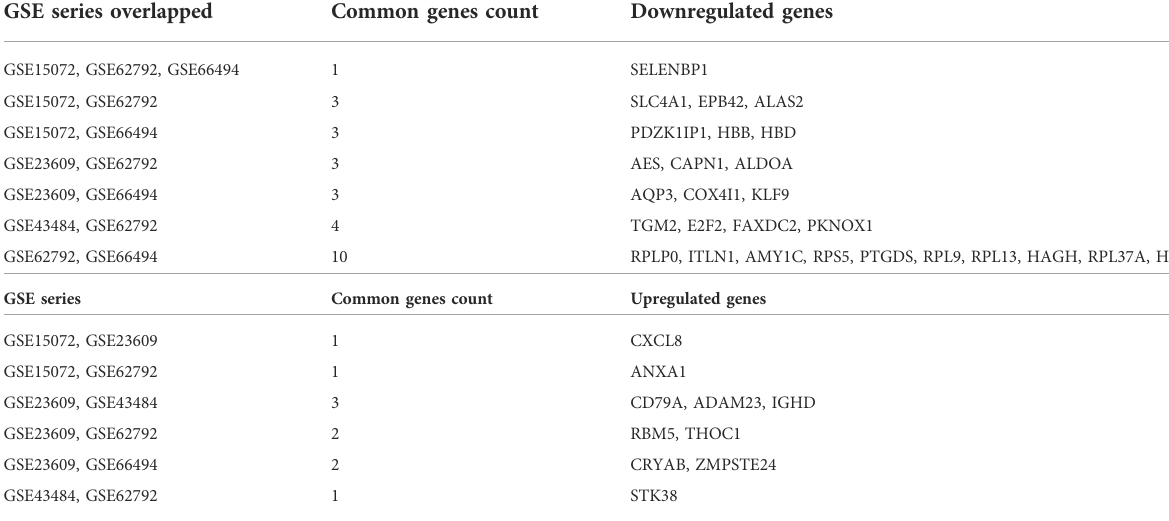
TABLE 2 The identi fi ed overlapped DEGs associated with CKD.